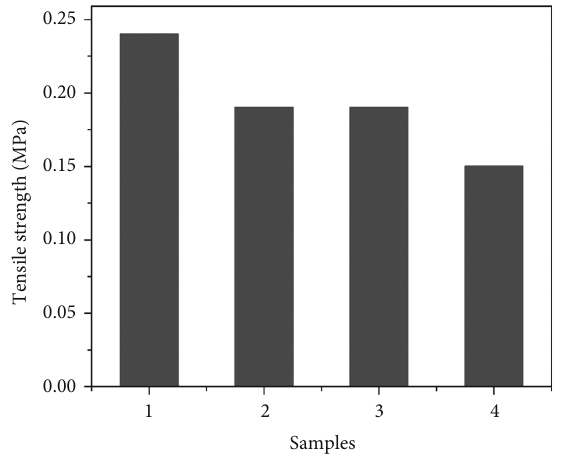
Figure 7: Tensile strengths of the PVA composite hydrogels with di ff erent APP-CS